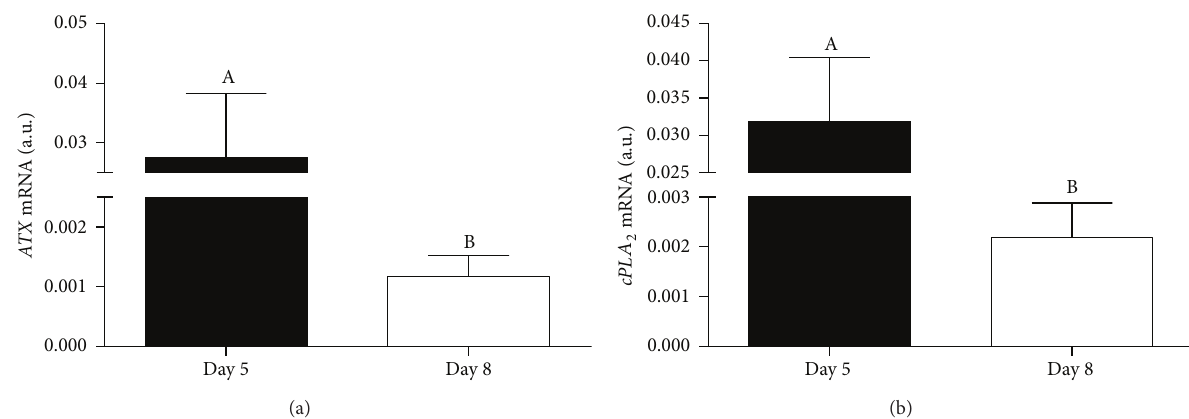
Figure 1: Transcription levels of genes coding for LPA synthesis enzymes ((a) ATX ; (b) cPLA 8) stage bovine in vitro produced embryos. Columns with different superscripts differ significantly: AB, 𝑃 < 0.05 .